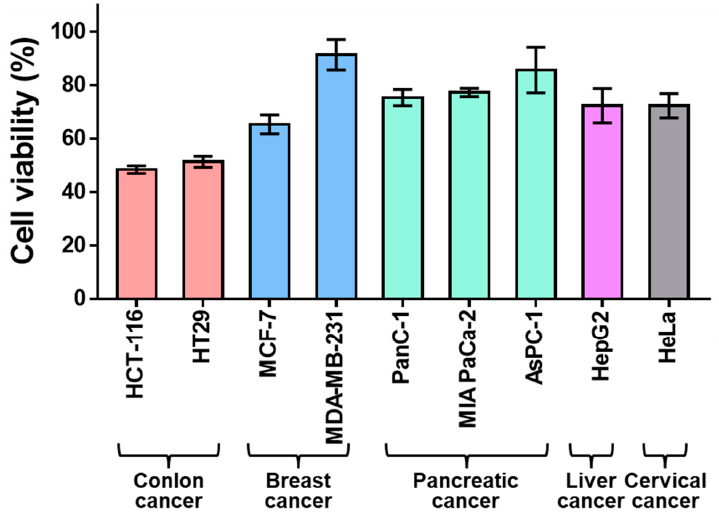
Figure 2. Anticancer efficacy of 6-MP (50 µ g/mL) against various cancer cells including colon cancer, breast cancer, pancreatic cancer, liver cancer, and cervical cancer cells.